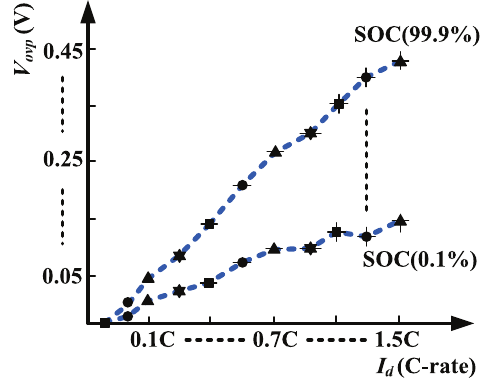
Figure 6. Example of the relations between the battery discharging current and overpotential voltages at various SOC